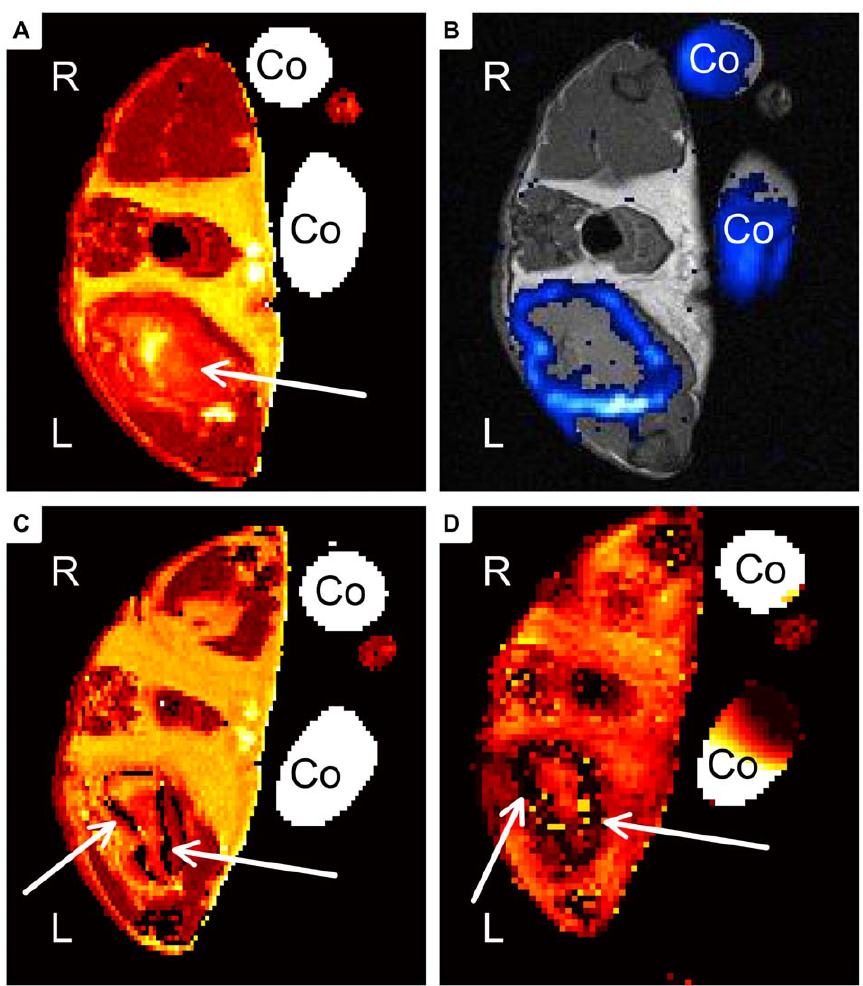
Figure 2. Representative MR Images of chronic soft-tissue infection. A, B) Mouse received PFC at day 8 post infection. Images were recorded 24 h after administration. C, D) Mouse received CLIO at day 8 post infection and was imaged 24 h after administration. A) Transverse T 2 map of PFC group mouse shows large hyper-intensity area within infected muscle (arrow). B) 19 F-SSFP CSI overlay on 1 H-TSE image of PFC group mouse shows strong accumulation of PFC at the rim of abscess area. C) Transverse T 2 map of CLIO group mouse shows hyper-intense area circumscribed by a dark rim (arrows). D) T 2 * weighted image shows strong susceptibility effects around the infected muscle in a hollow sphere pattern (arrows (Co: Control tube filled with PFC dilution, R: right side, L: left side of the imaged